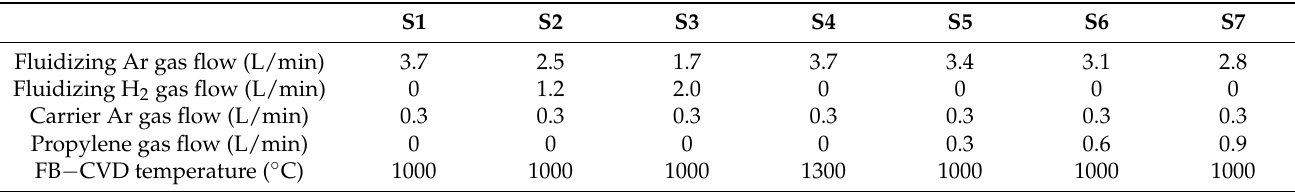
Table 1. Typical FB − CVD conditions to prepare the composite